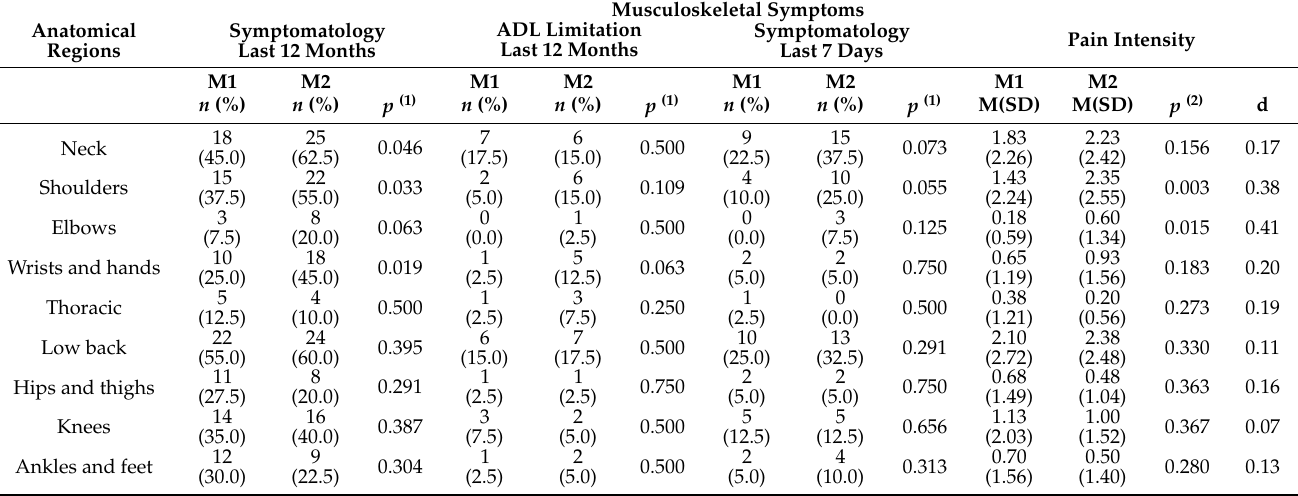
Table 2. Musculoskeletal symptomatology, limitation in daily activities and pain intensity in M1 and M2 ( n =